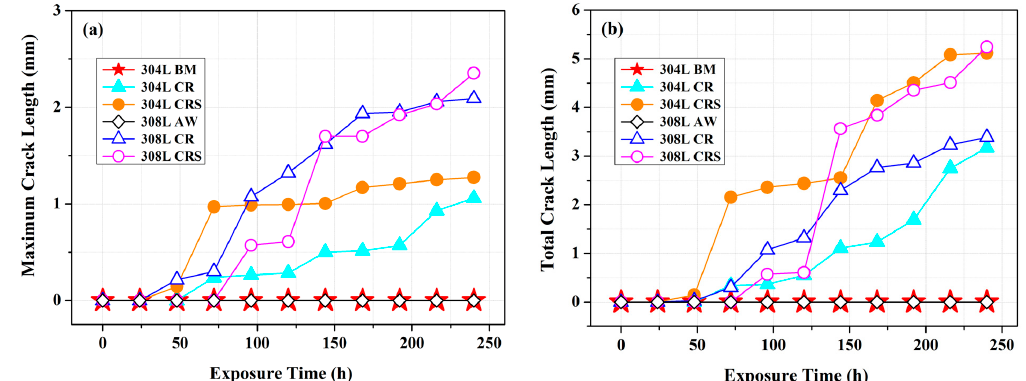
Figure 6. The variation in crack length of the U-bend specimens vs. the testing period in the salt-spray environment: ( a ) maximum crack length; and ( b ) total crack length.